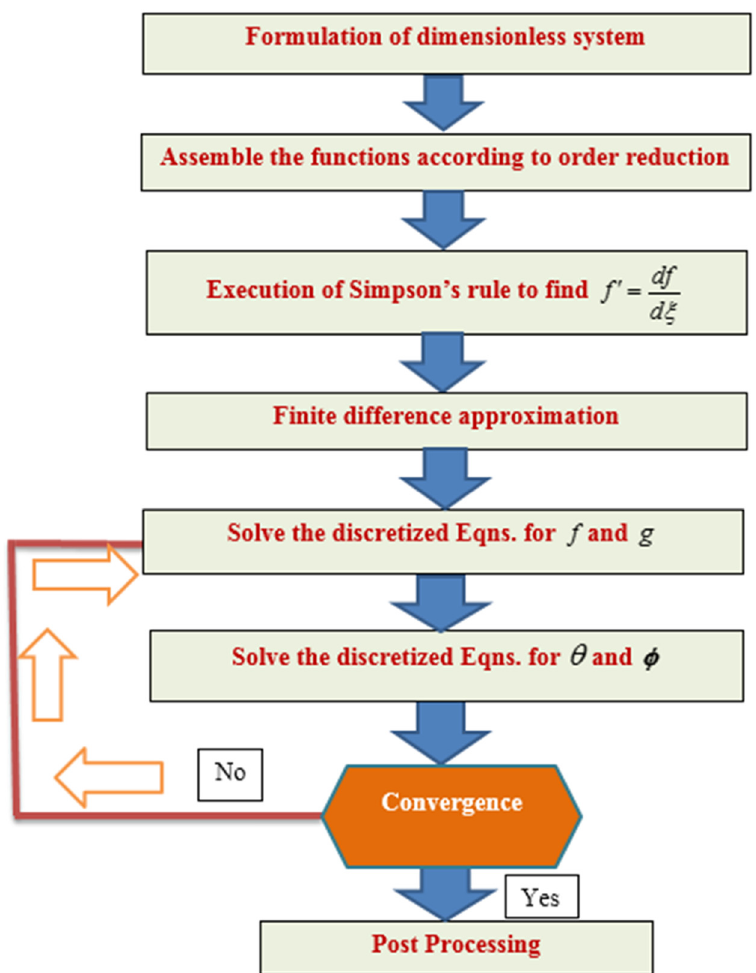
Figure 2: Structure of numerical algorithm.